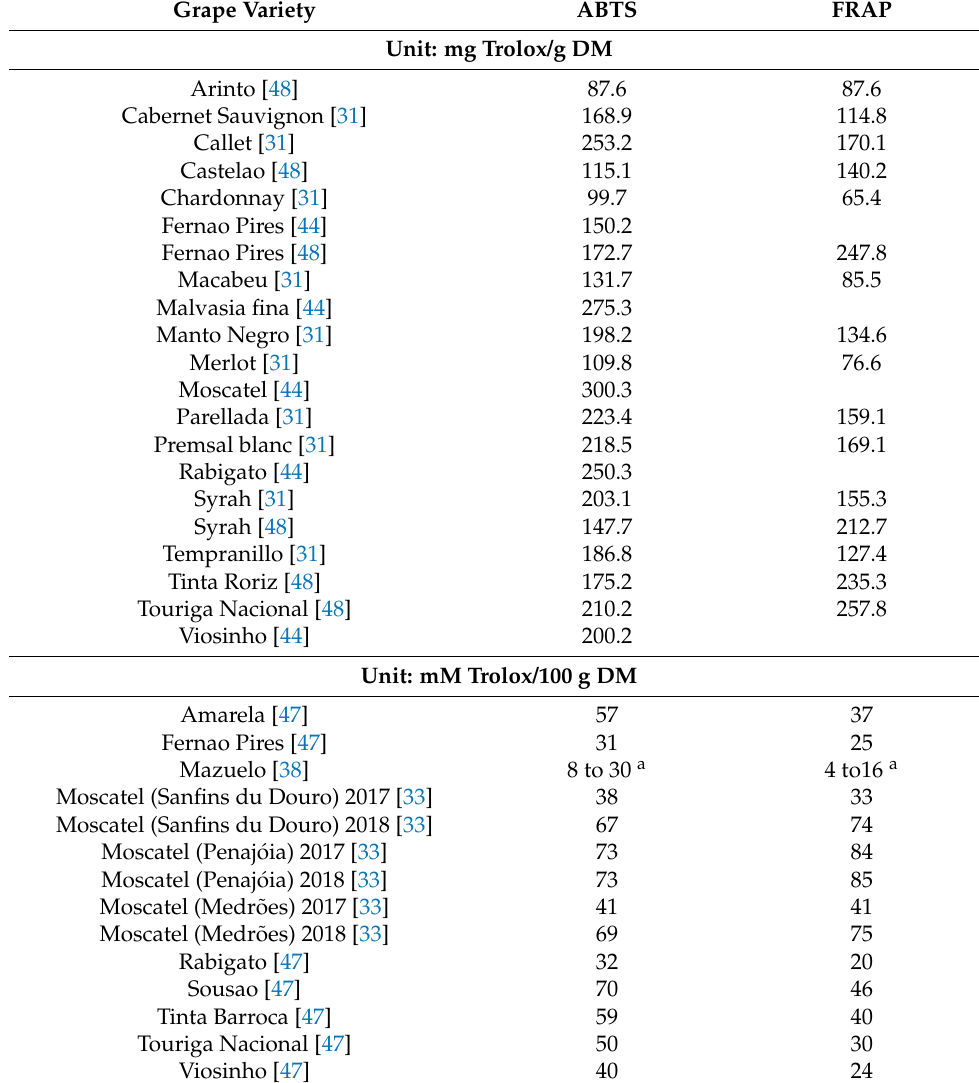
Table 10. Antioxidant activity of grape stem extracts (ABTS and FRAP